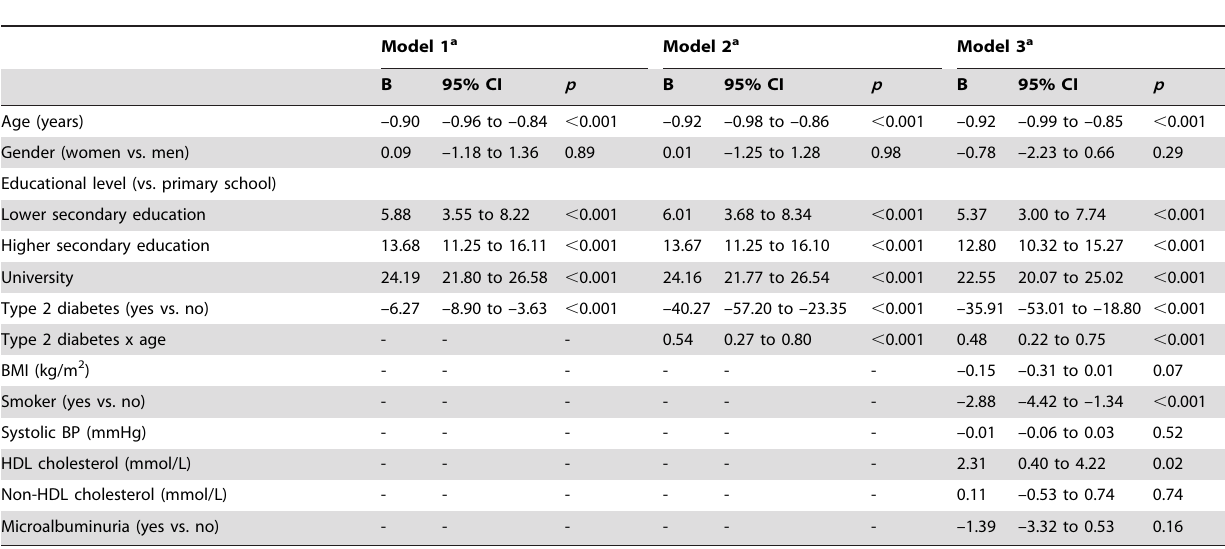
Table 2. Multiple linear regression analysis of Ruff Figural Fluency Test score on type 2 diabetes and